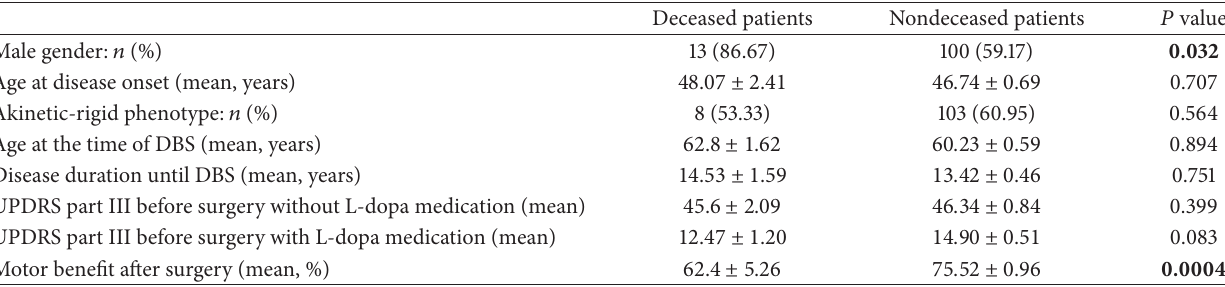
Table 1: Comparison between deceased patients and survivors.